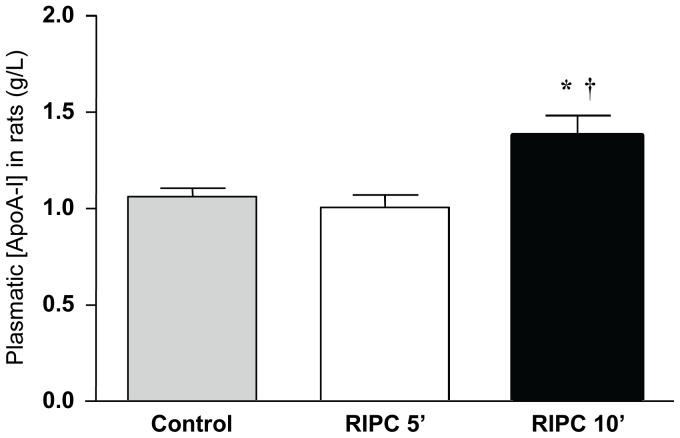
Validation of proteomic analysis by ELISA quantification of ApoA-I in rat plasmas.Results are expressed as mean ±SEM. *p<0.05 vs. RIPC 5′, †p<0.05 vs. Control, n = 10 in each group.